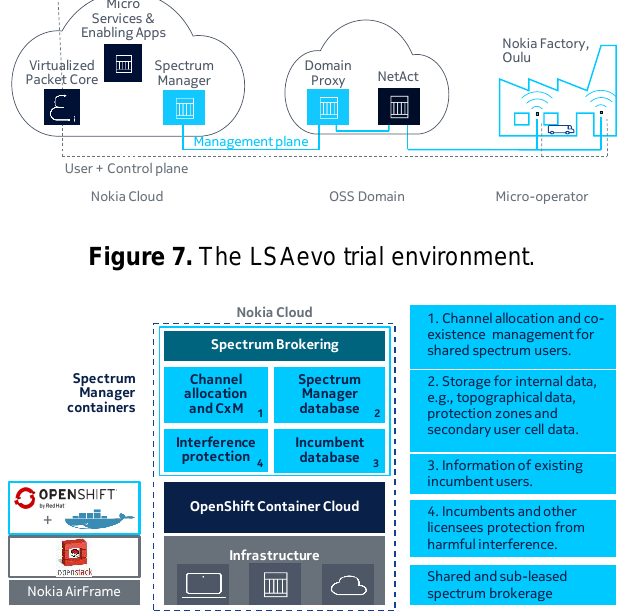
Figure 8. The LSAevo Spectrum Manager